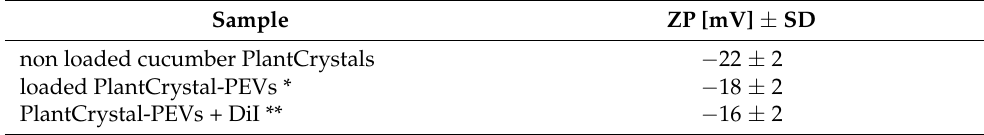
Table 2. Zeta potentials of cucumber PlantCrystals with and without AI-surrogate. Sample ZP [mV] ±